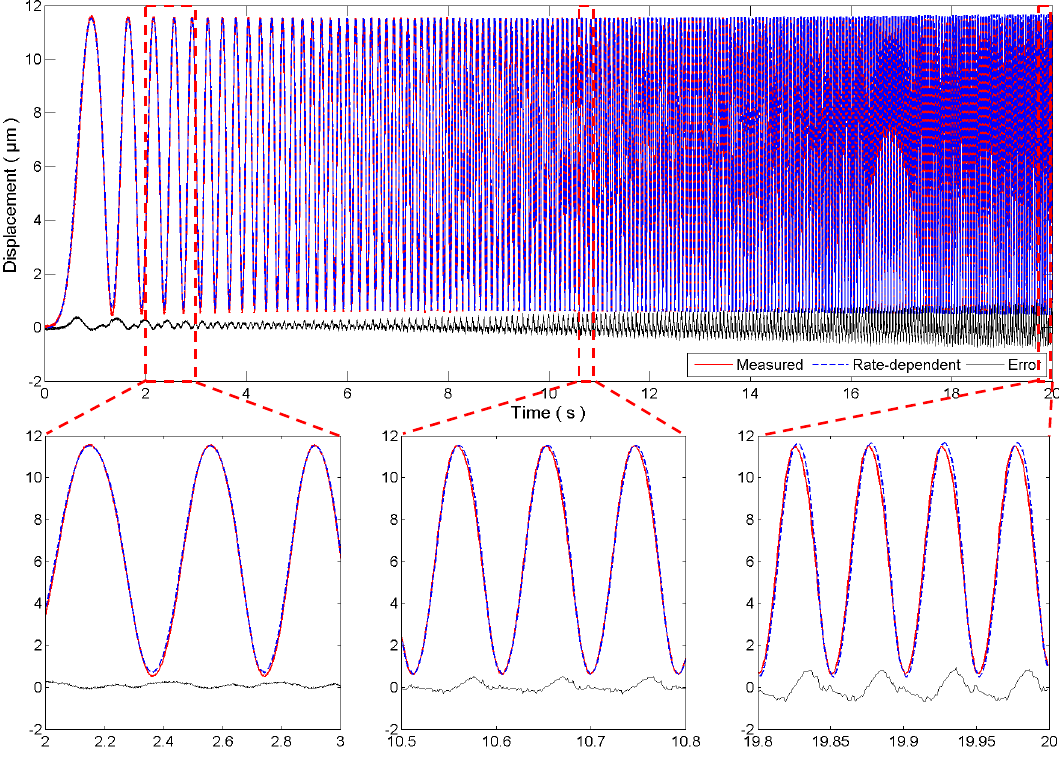
Figure 7. Verification of the rate-dependent model using a 0.1–20 Hz swept sinusoidal signal.